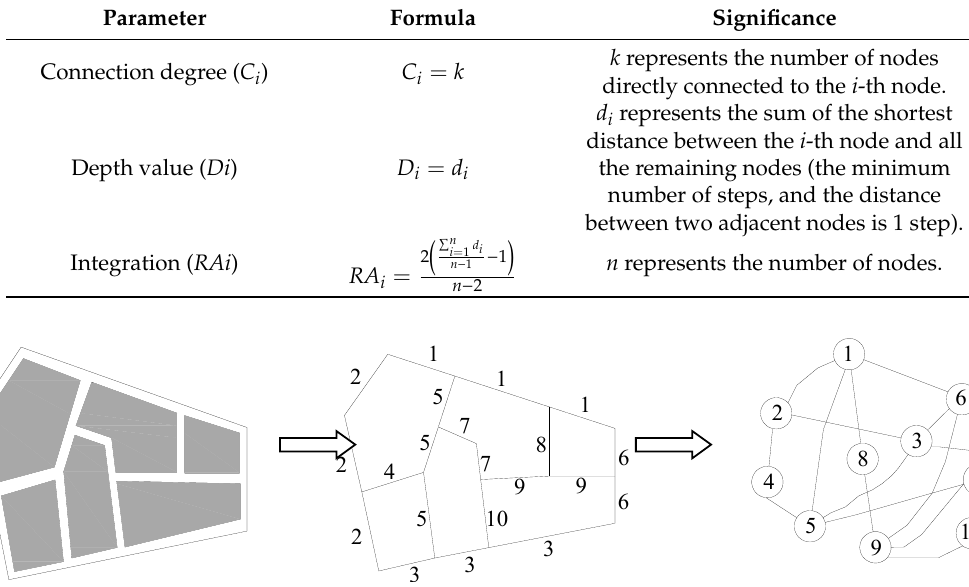
Figure 2. Illustration of the road Network, axis map and dual graph. Table 1. Space syntax parameters.